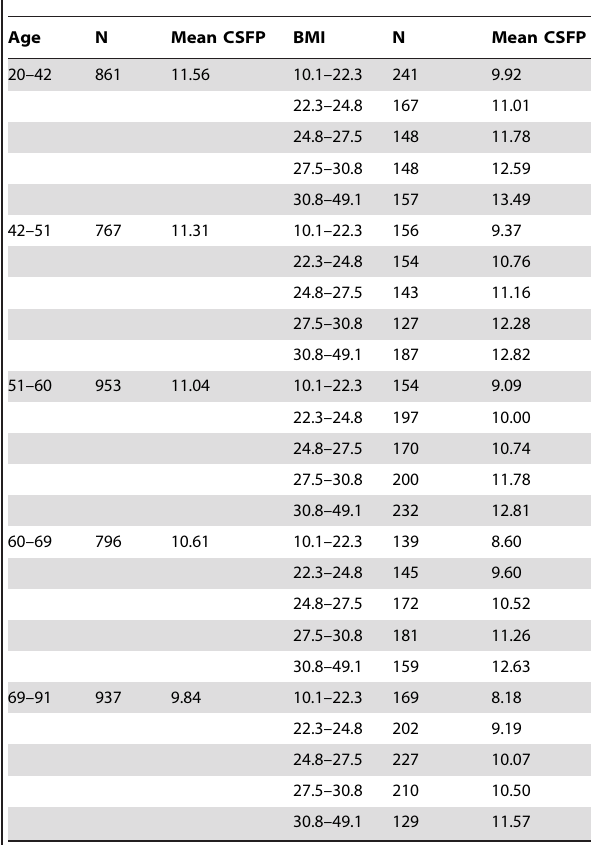
Table 5. Bivariate analysis of mean cerebrospinal fluid pressure (mm Hg) as a function of BMI within specific age